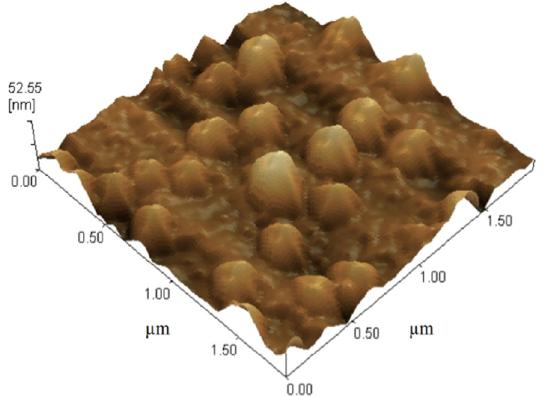
Figure 3. AFM photomicrograph of gliclazide-loaded nanoparticles (F3).